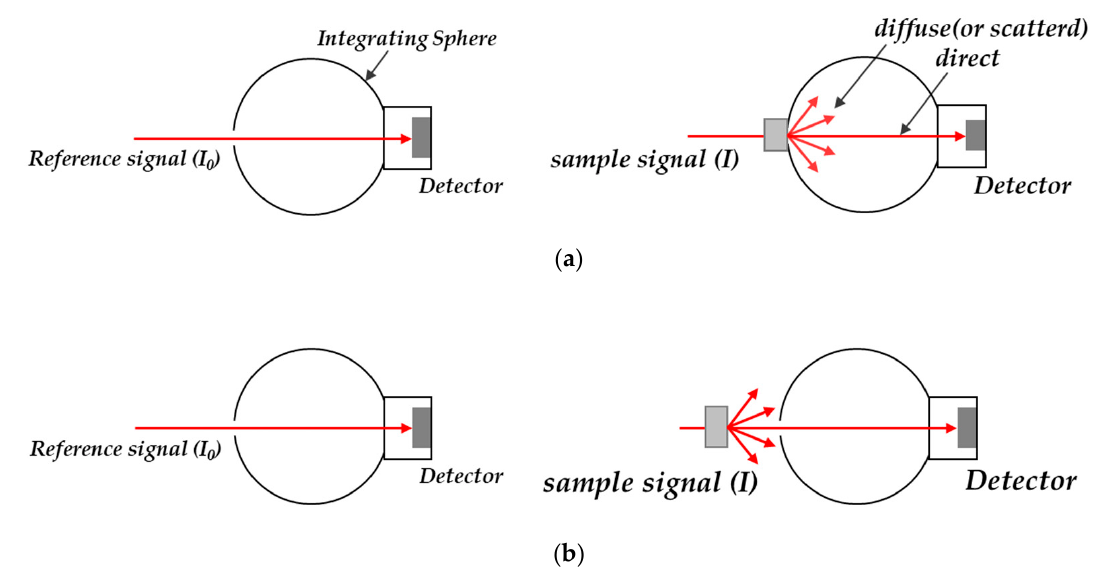
Figure5. Schematicdiagramsforthemeasurementof( a )totaltransmittanceand( b Figure 5. Schematic diagrams for the measurement of ( a ) total transmittance and ( b ) direct transmittance .